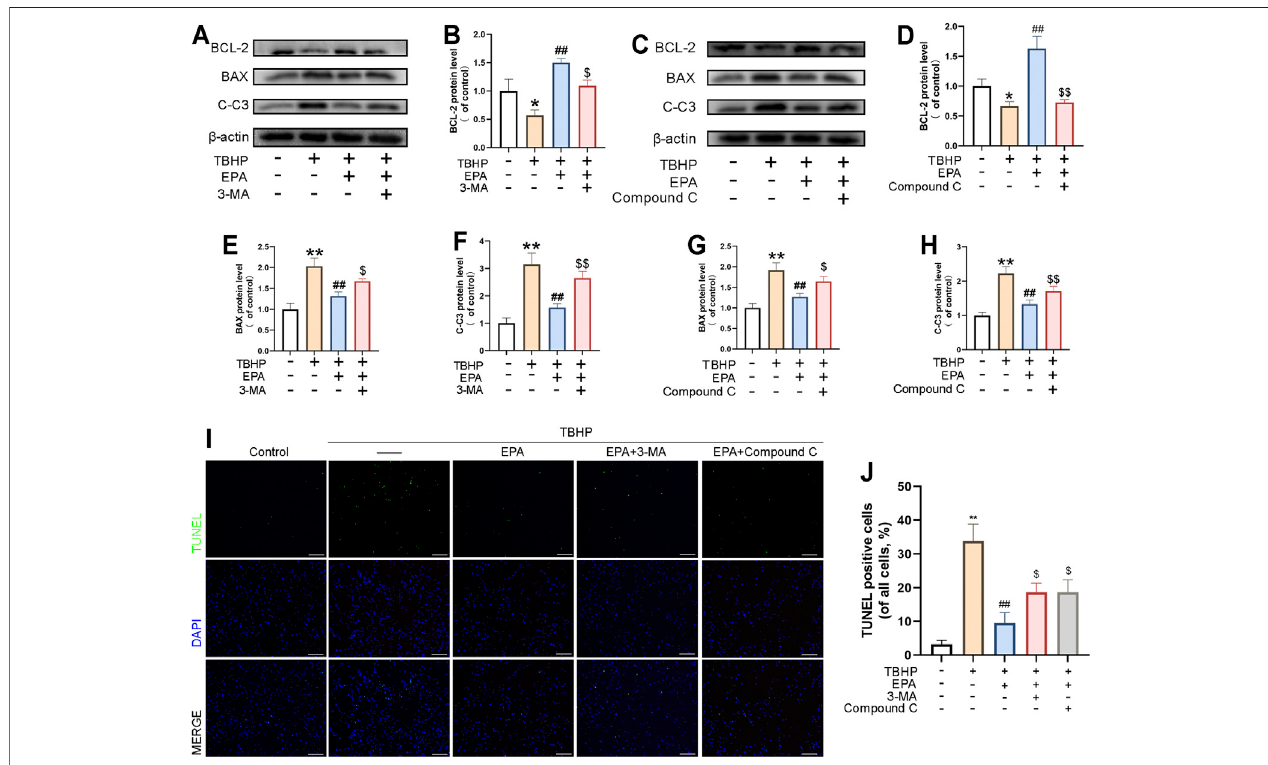
FIGURE 6 | TheInhibitionofEPAinPromotingAutophagy LeadtotheDeteriorationofEPAinRepairingApoptosis. (A – H) ThewesternblotresultsofBCL-2,BAX and Cleaved-caspase3inEPA ’ streatingwith3-MAorCompound CpretreatmentbeforeTBHPaddition. (I,J) TUNELassaywasperformedtoevaluatedtheapoptosisinNPCs treatedasaboveand apoptoticpositivecellswasquanti fi ed(scalebar: 100 μ m).Thevaluespresented arethemeans ± SD( n (cid:2) 3).* p < 0.05,** p < 0.01,comparedwiththe control group; # p < 0.05, ## p < 0.01, compared with the TBHP treatment group; $ p < 0.05, $$ p < 0.01, compared with the TBHP and EPA treatment group.